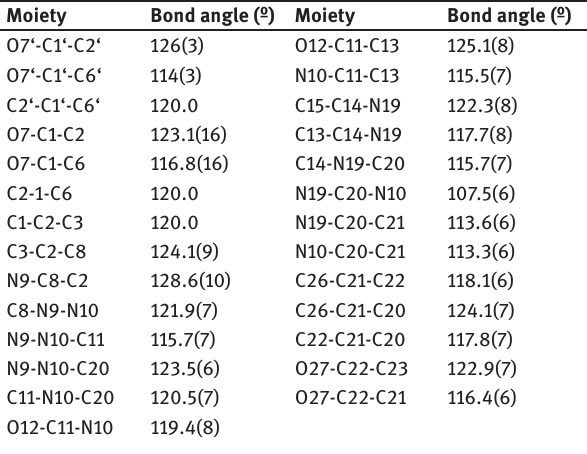
Table 3: Selected bond angles of